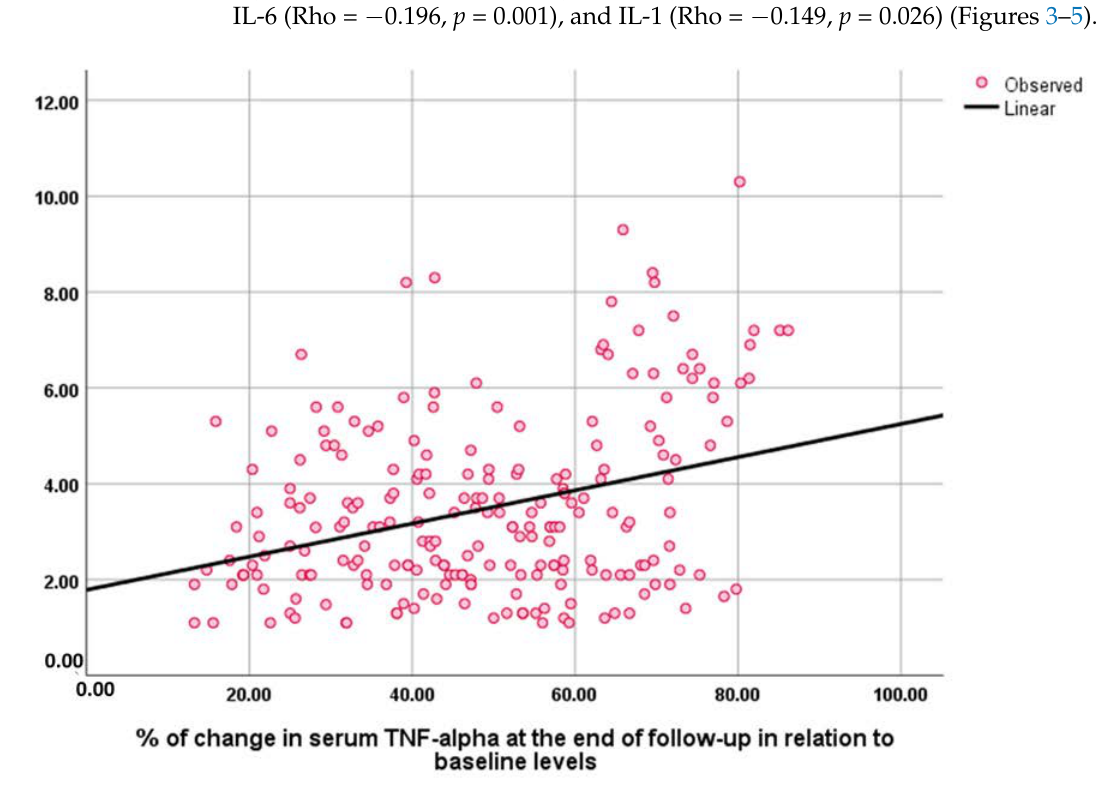
Figure 3. Correlation between the percentage of change in NESPY and serum levels of TNF - α at the end of the follow-up in relation to baseline levels.